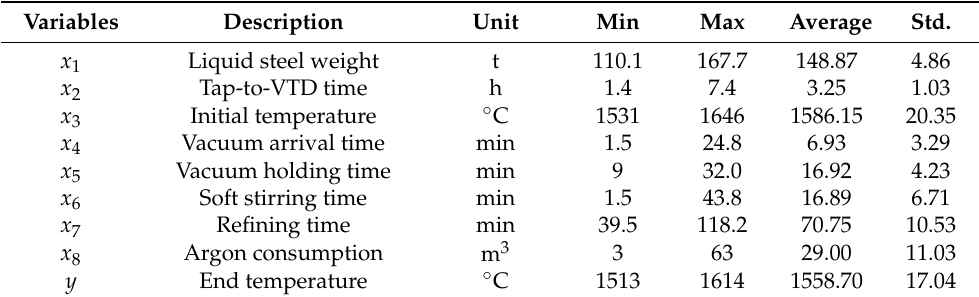
Table 3. Descriptive statistics of the process parameters.